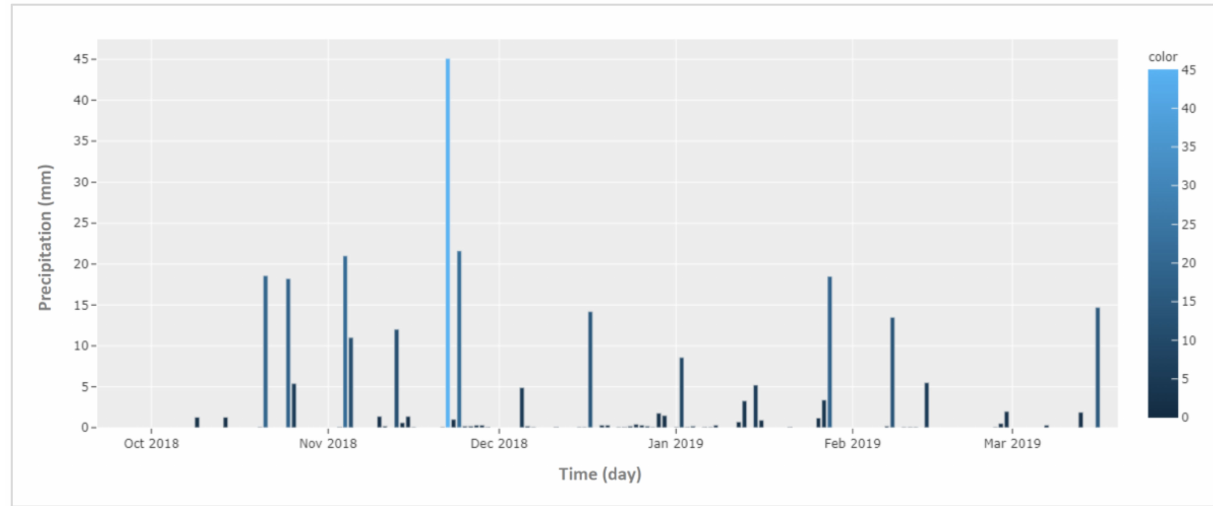
Figure 5. The daily precipitation in Ahvaz from October 2018 to March